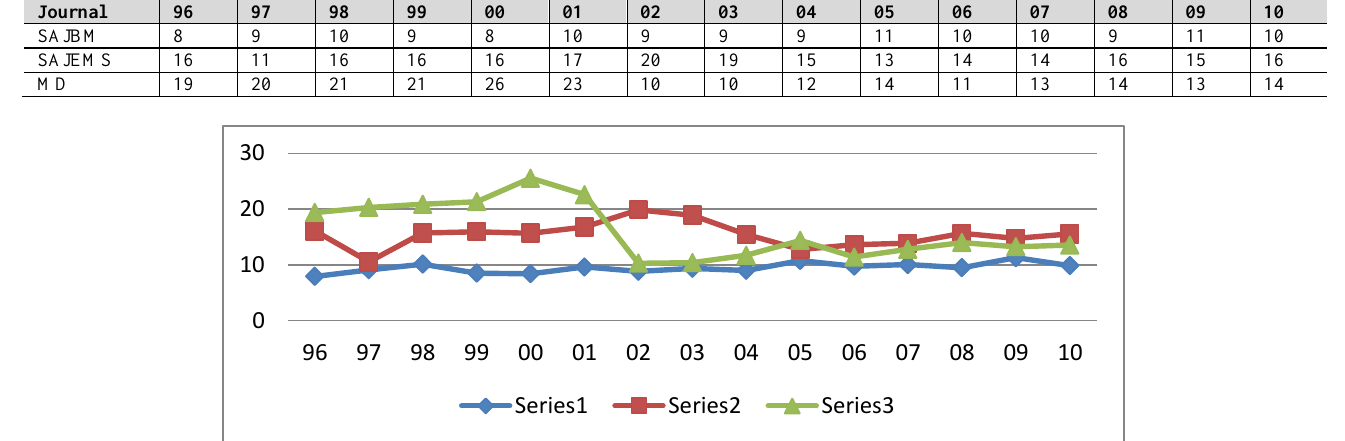
Table 9: Average page length of articles in all three journals over the past fifteen years Journal